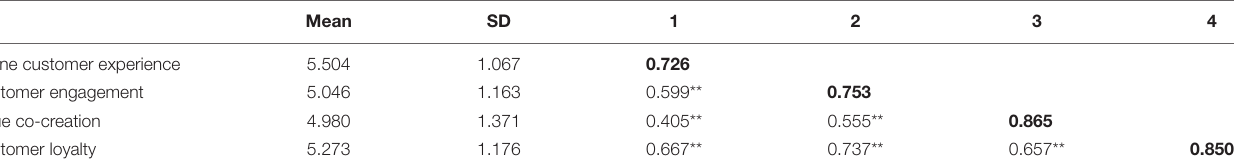
TABLE 3 | Correlations and discriminant validity.